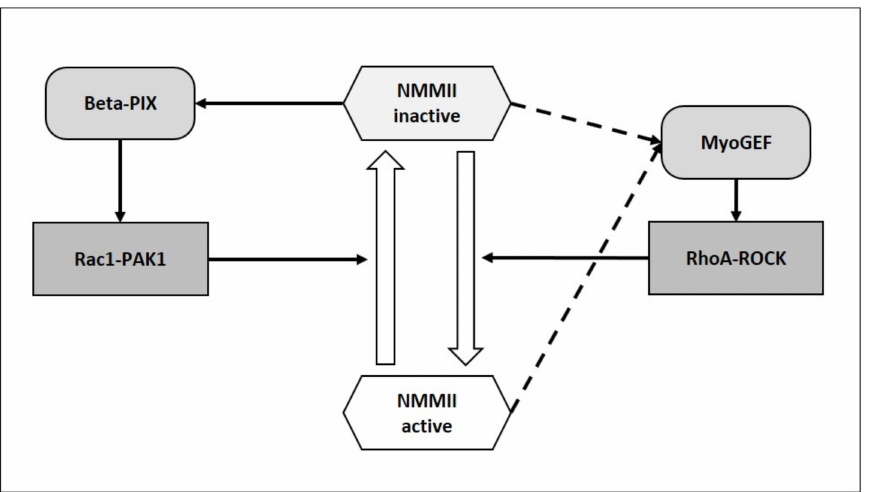
Figure 3. NMMII might induce positive feedback loops. When ATPase activity of NMMII is inhibited, it can release GEFs of the Dbl family, which are likely to further inhibit NMMII via activation of the Rac1-PAK pathway. It is not clear which state of NMMII (active or inactive ATPase activity) can induce the release of active MyoGEF. Active MyoGEF can stimulate NMMII via activation of